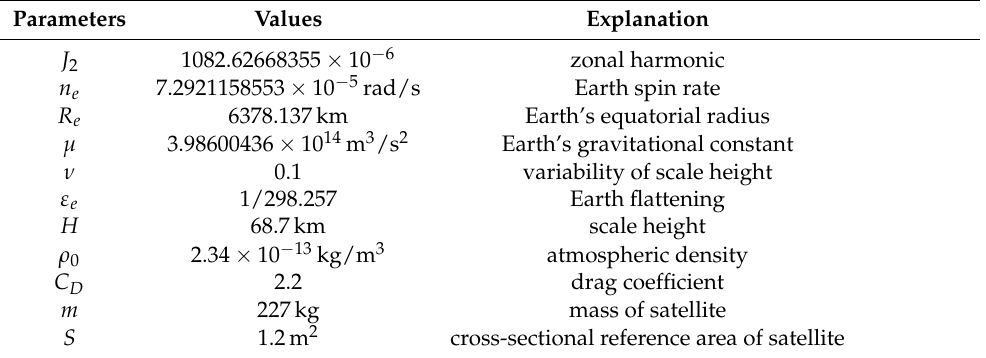
Table 2. Analytical model coefficients